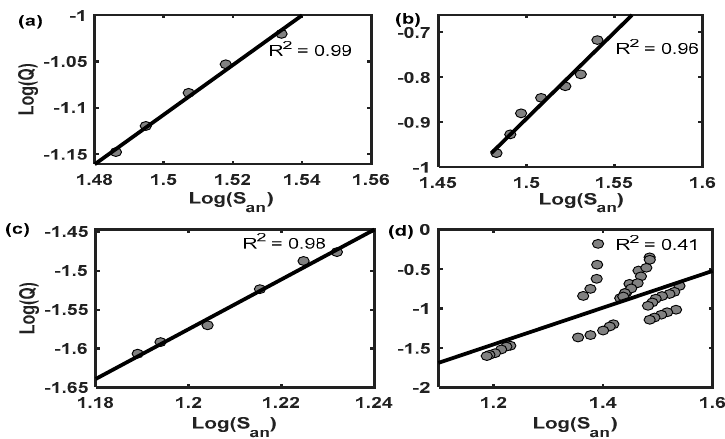
Figure 3. Q vs. S an scatter plots for three recession events from the sample basin 02053800 ( a – c ). Although the correlations are strong (R 2 in each case is greater than 0.96), the relation between the two variables is clearly not unique ( d ), which supports the notion that Q –S an relationship is dynamic, not static. Note that to limit the influence of observational errors in the analysis we selected only the recession curves for which both S an and Q continuously decreased over time.